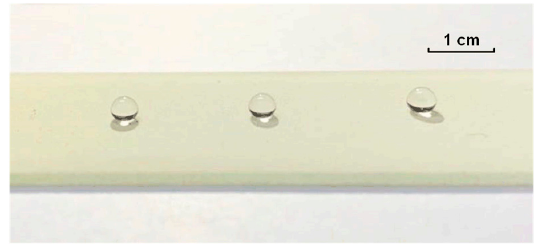
Figure 7. Hydrophobic performances of the super-hydrophobic coating after the sandpaper wearing test.